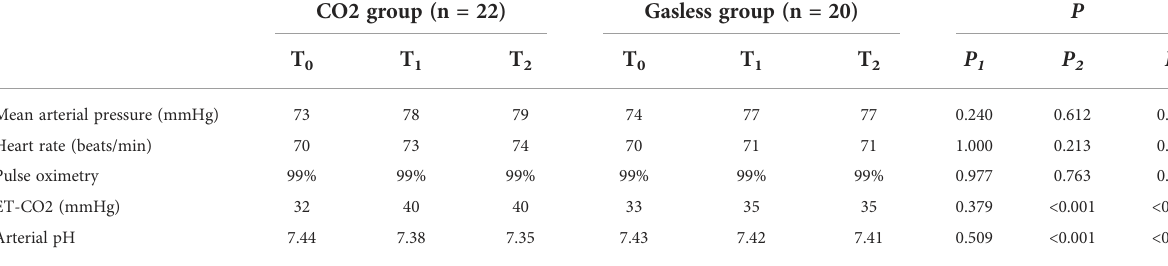
TABLE 2 Intra-operative hemodynamic parameters of the two groups.